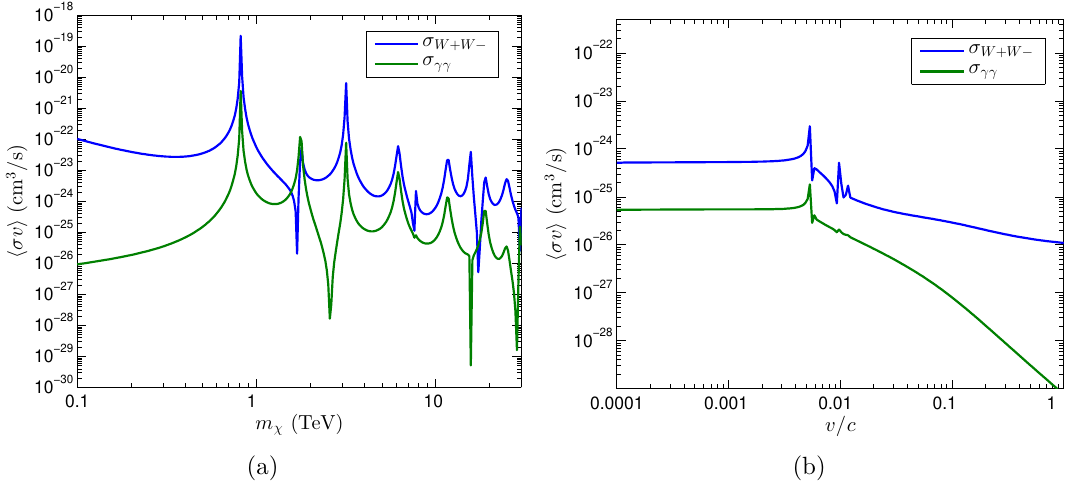
Figure 17. Annihilation spectrum of the real quintuplet dark matter pair χ 0 χ 0 into W + W − (blue) and γγ (red) vectors, with respect to DM mass at v = 10 − 3 c (17(a)), and to the DM velocity at freeze-out mass of m 0 = 9 . 4 TeV